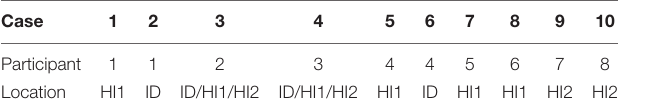
TABLE 4 | Heart rate variability cases (Hill,